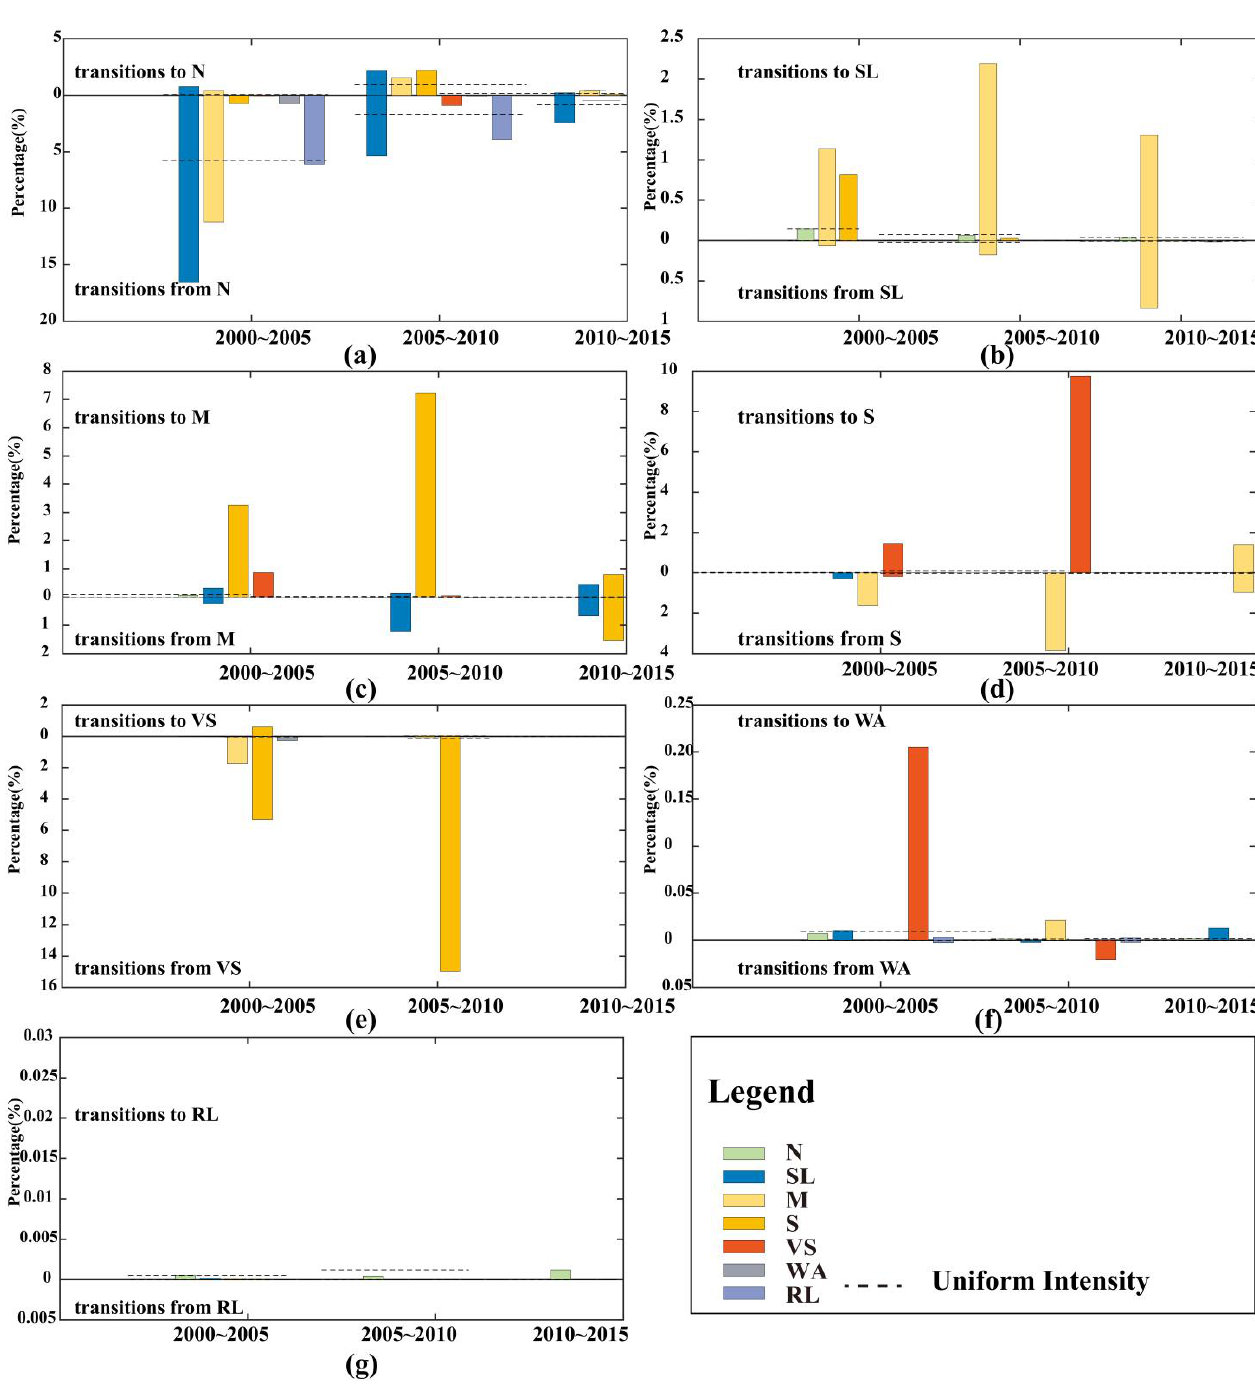
Figure 8. Transition area and intensity changes for different types of land in the three counties of Mongolia . of